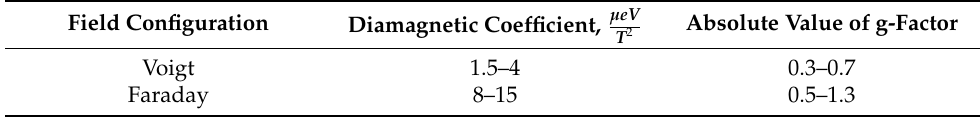
Figure 6. Summarized diamagnetic coefficients ( left ) and g-factors ( right ) from Voigt (solid black squares) and Faraday (solid red circles) configurations as a function of emission energy. Solid lines are to guide the eye. Table 1. Summary of experimentally determined trion